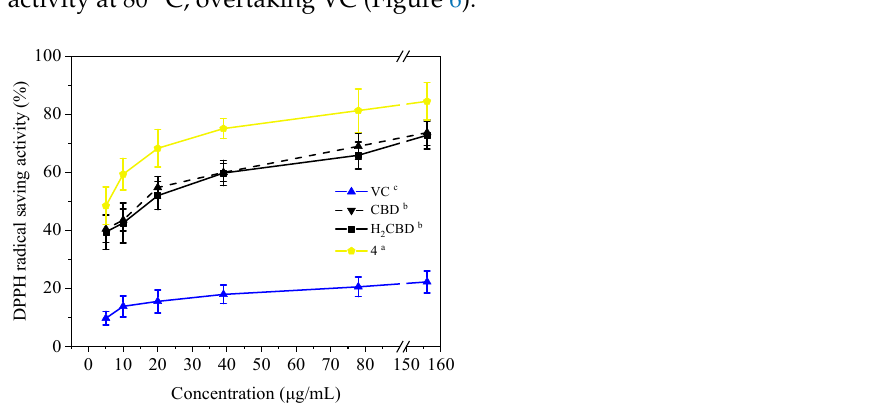
Figure 6. DPPH assay of the CBD analogues and VC at 80 °C. Different letters present the data significance.